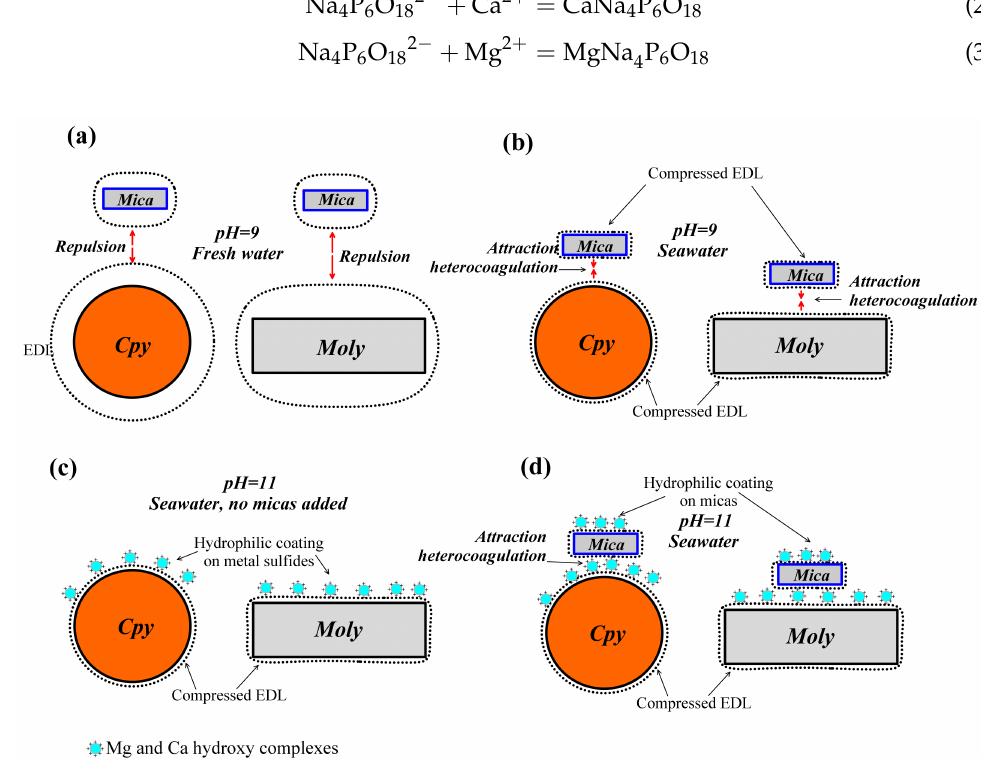
Figure 9. Suggested mechanisms of interactions between mica particles, and chalcopyrite (Cpy) and molybdenite (Moly) in ( a ) freshwater, ( b ) seawater pH = 9, ( c ) seawater pH = 11 no micas added, ( d ) seawater pH =